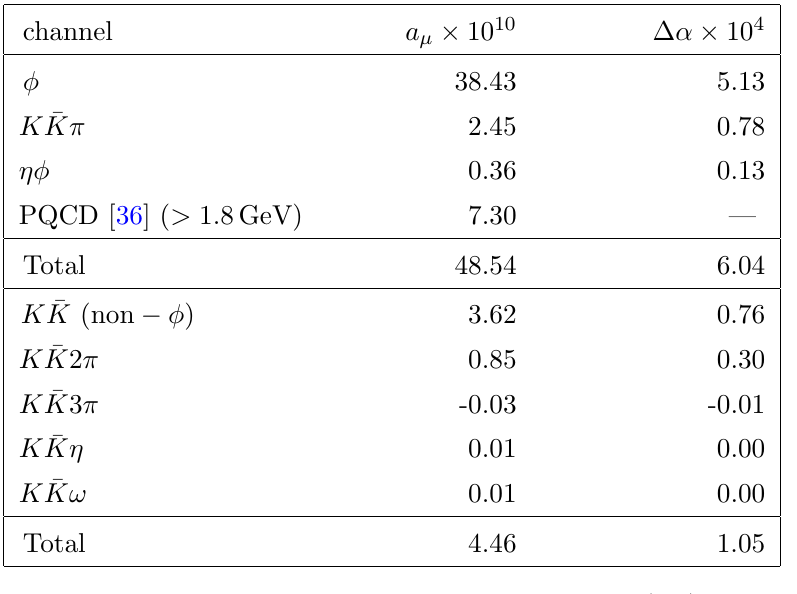
Table 3 . Channels associated with the strange quark external current (top) and possible further channels originating from it